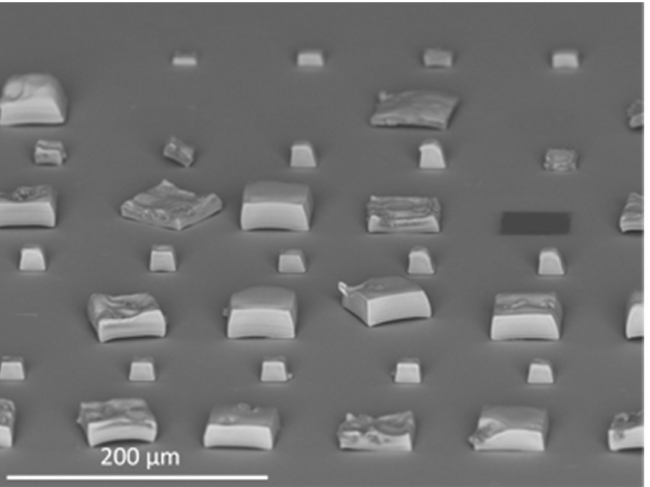
Figure 4. Smaller cuboids (20 µ m × 20 µ m × 30 µ m) and cuboid structures with larger edge length (50 µ m × 50 µ m × 30 µ m), structured with 10 mm/s fabrication velocity and 20 mW average laser